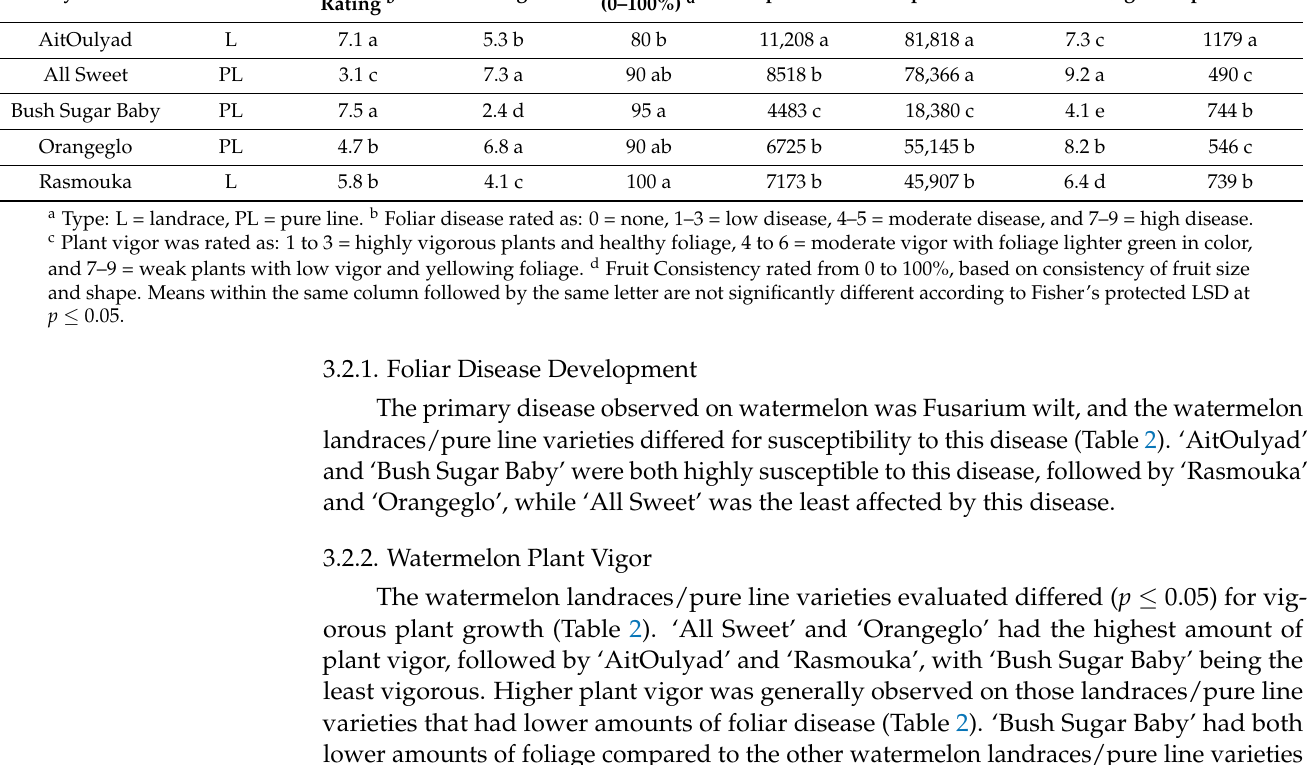
Table 2. Watermelon ( Citrullus lanatus ) variety/landrace evaluations in Belfaa, Morocco combined for 2015 and 2016. Watermelon